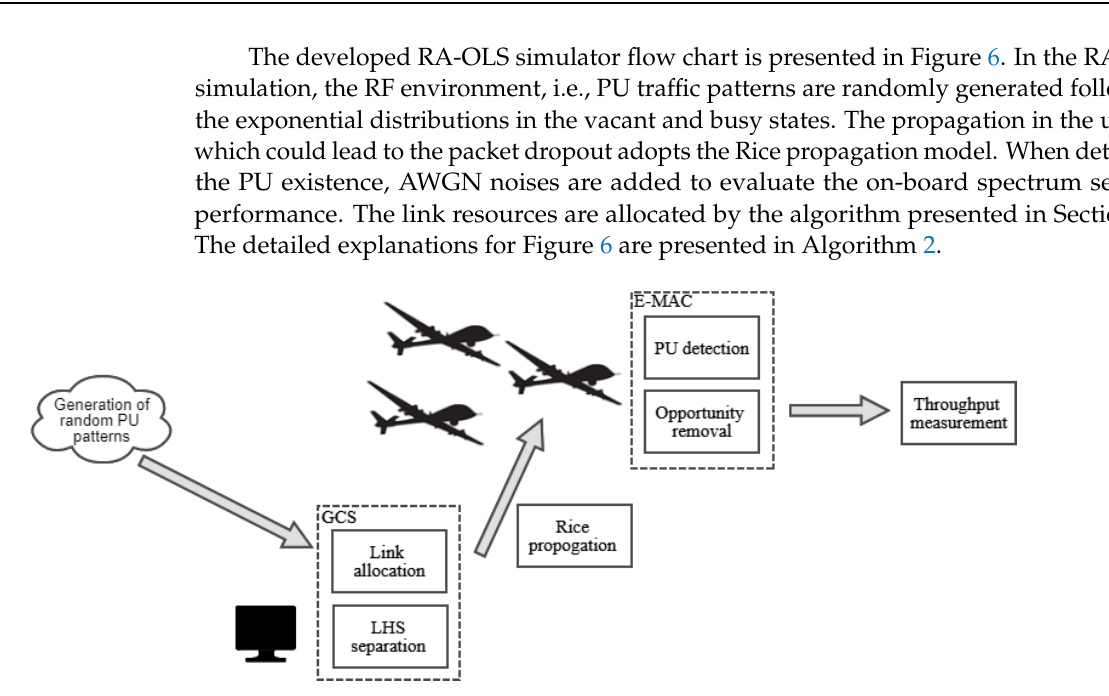
Figure 6. Simulation flow chart for dynamic spectrum sharing with RA-OLS